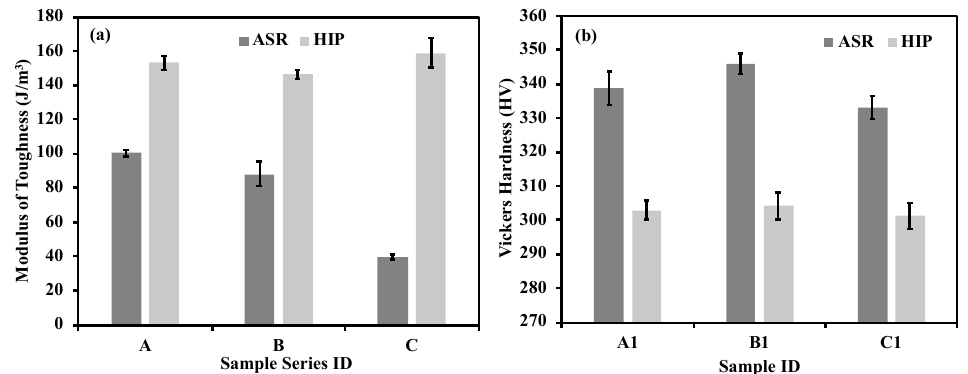
Figure 3. ( a ) Modulus of toughness and ( b ) Vickers hardness determined for the as stress-relieved (ASR) and hot-isostatically pressed (HIP) Ti-6Al-4V ELI alloy samples. Uncertainty in ( a ) was determined from stress-strain curves (average and standard deviation from area under the curve). Standard deviation from ( b ) was determined from five measurements from random